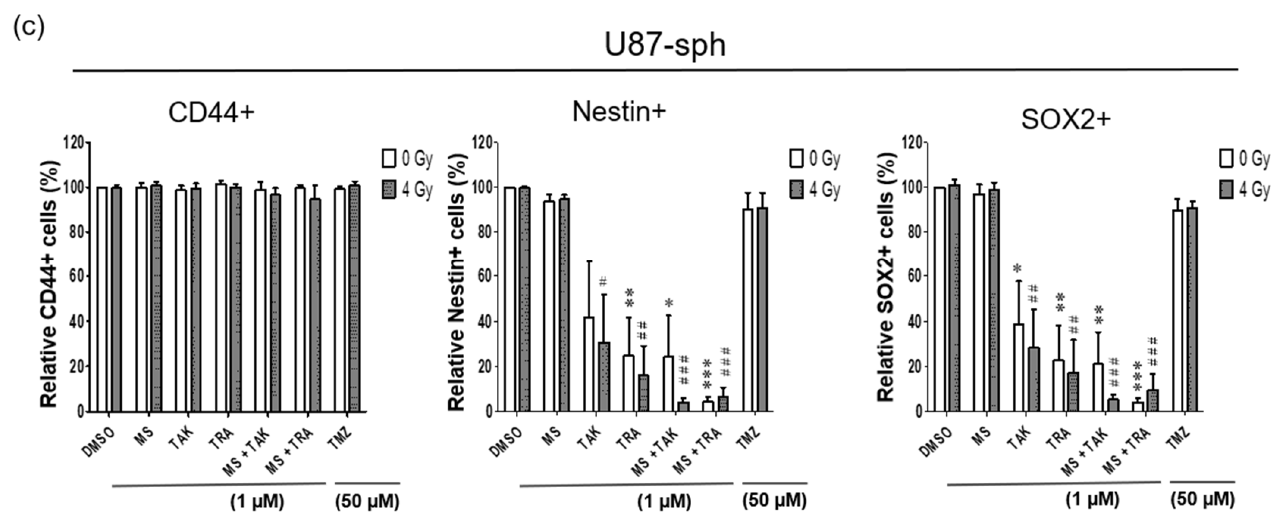
Figure 5. Single expression of GSLC markers reduced by the combination of HDAC and MEK inhibitor with radiation. ( a ) Representative example of flow cytometric histograms of Nestin in U251-sph 72 h after the spheres were treated with HDCAi (1 µM MS-275), MEKi (1 µM TAK-733 or 1 µM trametinib), a combination of both (1 µM MS-275 + 1 µM TAK-733 or 1 µM MS-275 + 1 µM trametinib) and 50 µM TMZ alone or with 4 Gy radiation. Upper histograms represent the unstained sample and fluorescence minus one (FMO) control for the gating percentage of Nestin-positive cells (Nestin+). Lower histograms show the percentage of Nestin-positive cells after the indicated treatment conditions and 4 Gy irradiation. Values inside each histogram represent the percentage of positive single cells from a total of approximately 2 × 10 4 cells acquired. ( b ) Quantification of CD44+, Nestin+ and SOX2+ relative to sham irradiated control cells (DMSO) set to 100% in U251-sph and ( c ) U87-sph. Data represent means ± SEM ( n = 3). Asterisks indicate significant differences between 0 Gy DMSO and treated samples using Student’s t -test: * p ≤ 0.05, ** p ≤ 0.01 and *** p ≤ 0.001, while hash symbols indicate significant differences between 4 Gy DMSO and 4 Gy treated samples using Student’s t -test: # p ≤ 0.05, ## p ≤ 0.01 and ### p ≤ 0.001.